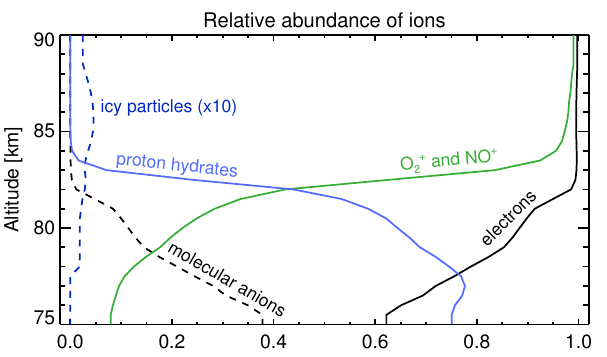
Fig. 12. Modelled daily mean relative abundance of the most impor- tant ions as a function of altitude on 18 January at 75 ◦ S. Note that the ratio of negatively charged icy particles is increased by a factor of ten.